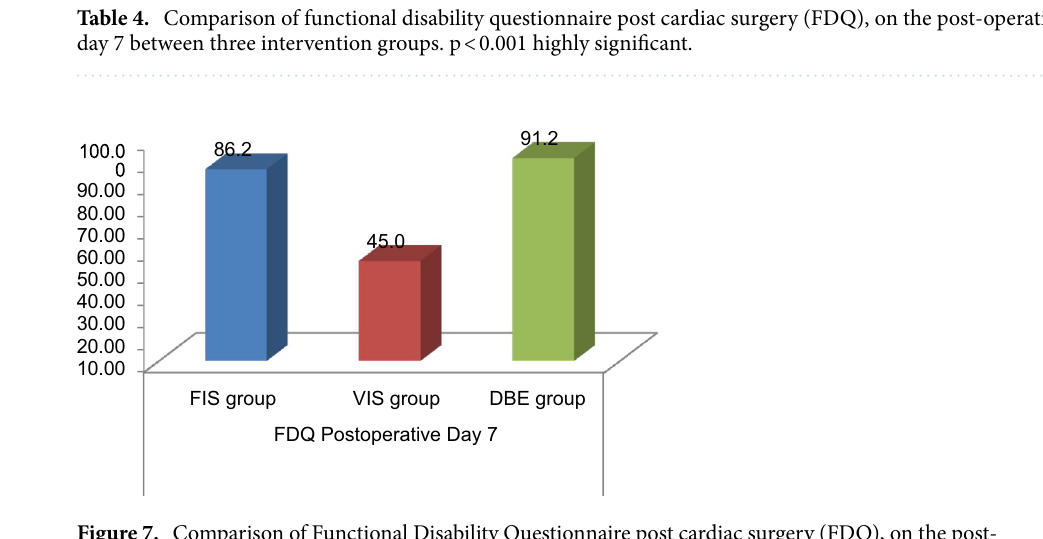
Figure 7. Comparison of Functional Disability Questionnaire post cardiac surgery (FDQ), on the post- operative day 7 in the three intervention